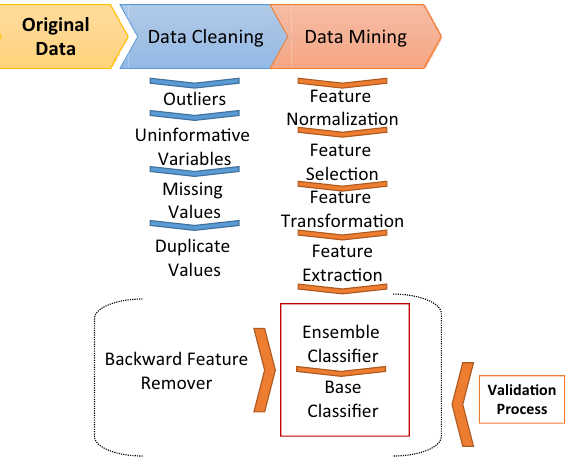
Figure 1. Biomarker data mining analyses procedure. First, a Data Cleaning process was performed to eliminate outliers, uninformative variables, missing values, and duplicate variables. Next, this new cleaned data set was used to train the model of the Data Mining process which is subdivided in different mathematical sub-processes: Feature Normalization, Feature Selection, Feature Transformation, Feature Extraction, Ensemble Classifier, Base Classifier, Backward Feature Removal and Validation. The Feature Normalization guarantees that the values of all variables are in the same range. The Feature Selection is applied to select the input variables that show the strongest relationship with the outcome. The Feature Transformation consists in mathematical transformations of the input data required for the Base Classifiers. It was not necessary to apply a Feature Extraction to reduce the number of random variables. Different algorithms generated different Base Classifiers with a good performance. Ensemble Classifiers were able to improve the performance of the Base Classifiers. Finally, the Validation process to estimate the accuracy of the predictive model was performed using the original database by several methods: 10-K fold and